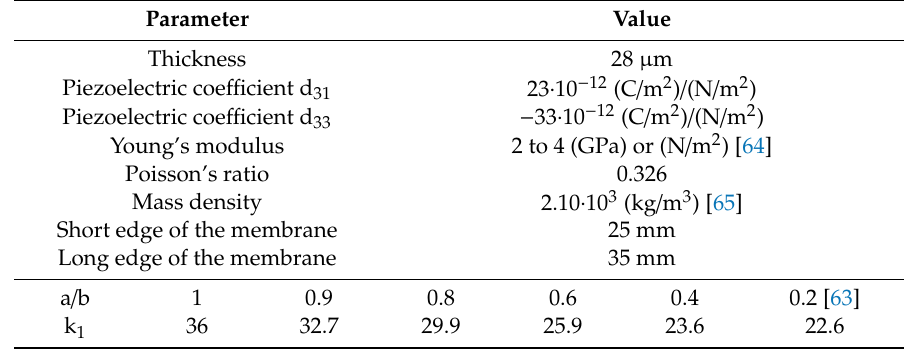
Table A1. Parameters of the PVDF films and values for the calculation of the fundamental